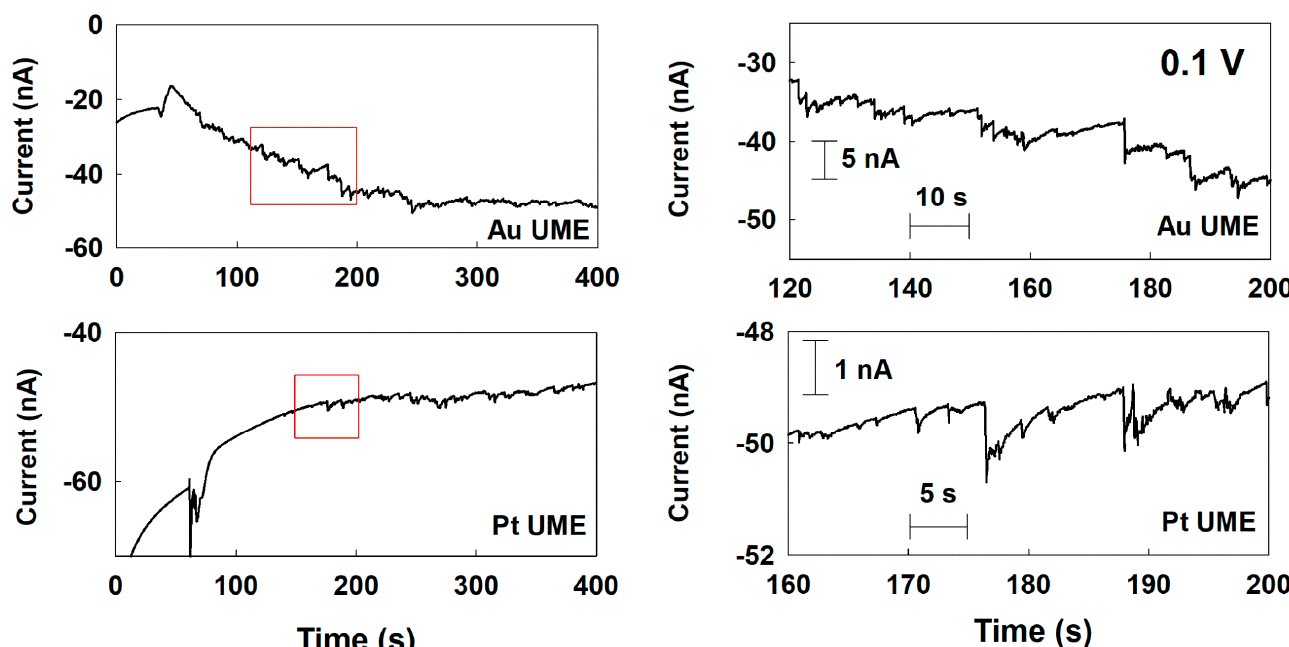
Figure 3. Chronoamperometric curves for a single-Pd-NP collision at the Au and Pt UMEs with a potential of 0.1 V (vs. Ag/AgCl) applied in a 50 mM phosphate buffer (pH 6.8) containing 15 mM hydrazine. The Pd NP concentration was 160 pM. The data acquisition time was 50 ms.